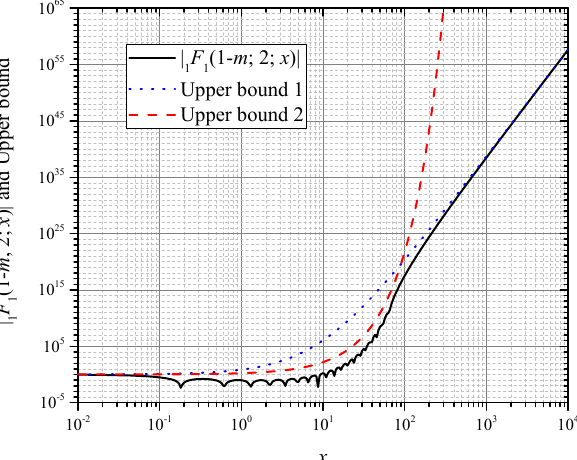
Figure 3. Two upper bounds for | 1 F 1 ( 1 − m ;2; x ) | , for m =